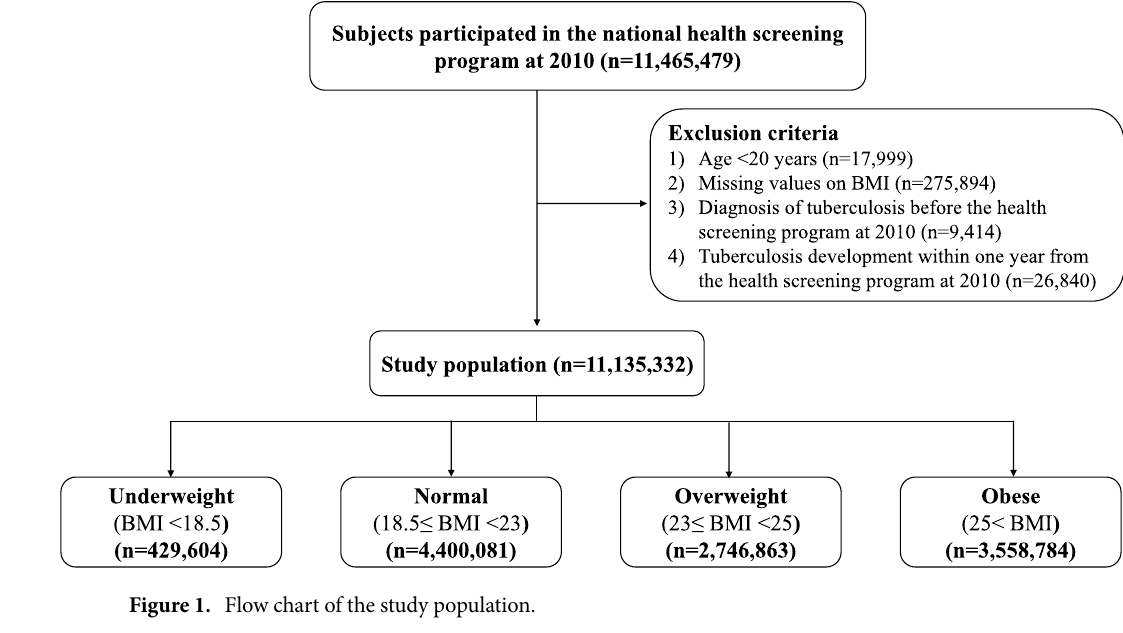
Figure 1. Flow chart of the study